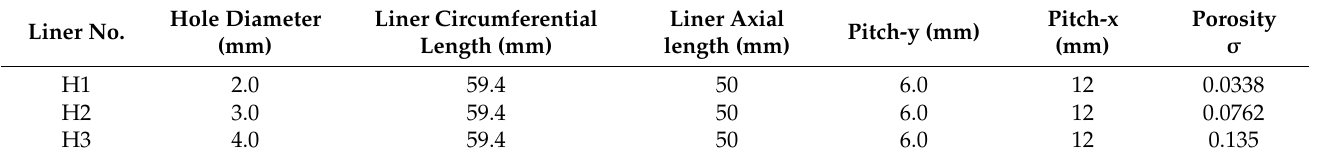
Table 1. Geometry features of perforated liners H1, H2 and